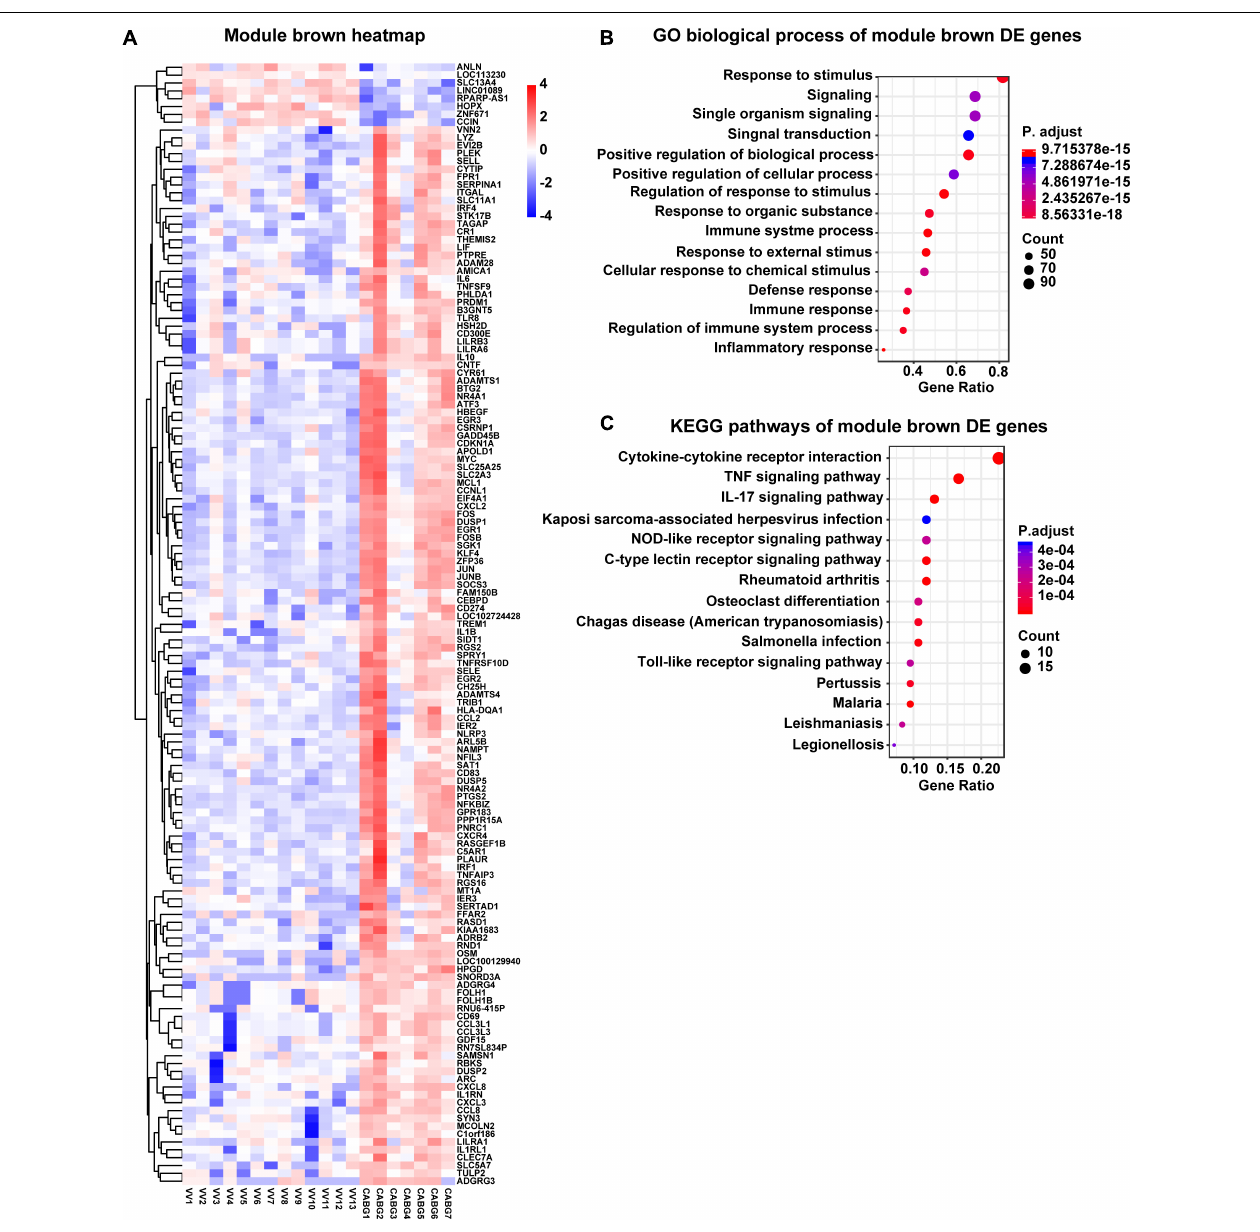
FIGURE 2 | Gene functional analysis of module brown genes. (A) Gene expression of module brown genes with RNA-seq data. (B) Gene ontology analysis and (C) Kyoto encyclopedia of genes and genomes (KEGG) pathway analysis of module brown